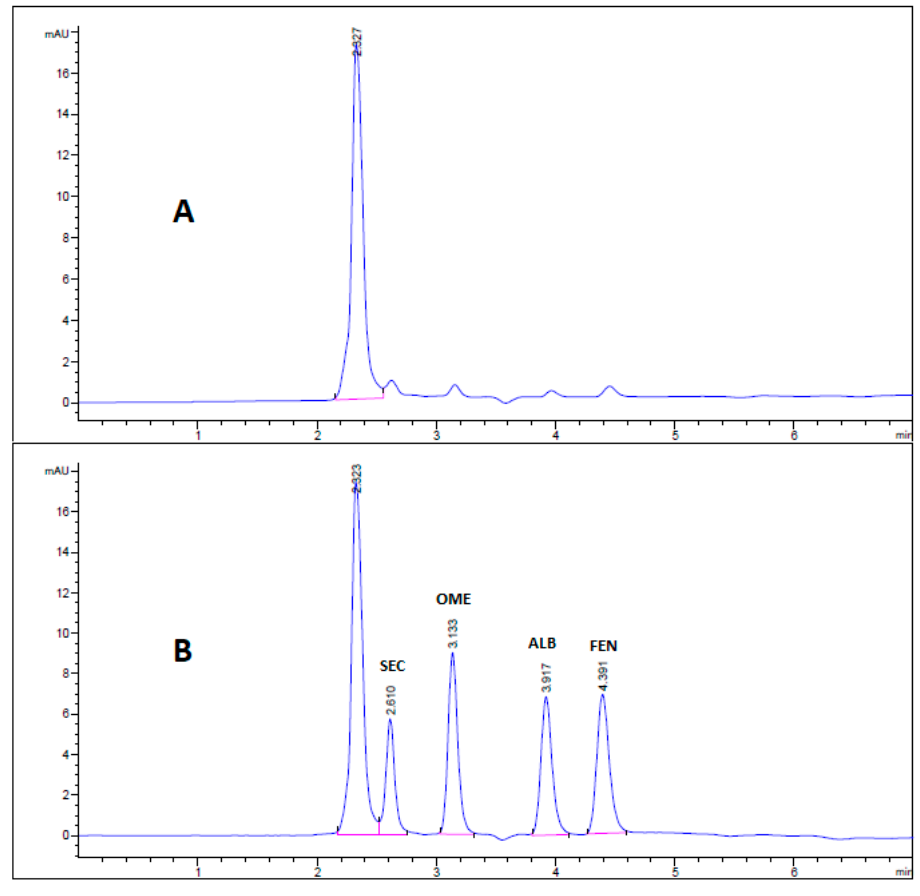
Figure 4. HPLC Chromatogram of Secnidazole ® , Omez ® , Alzental ® , and Curafluke ® dosage forms. All optimum chroma- tographic conditions are stated in Table 1.